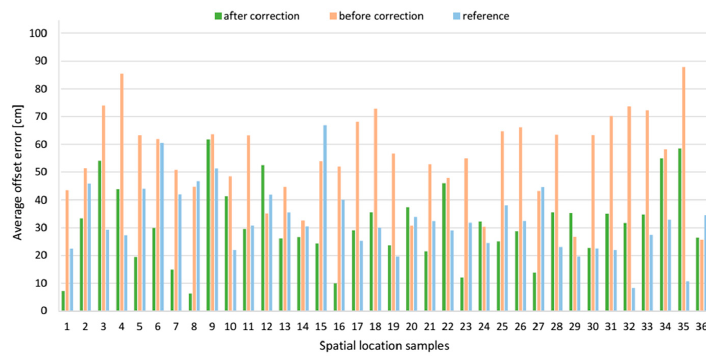
Figure 20. Comparative bar plots of the average resultant offset error for AB pair.